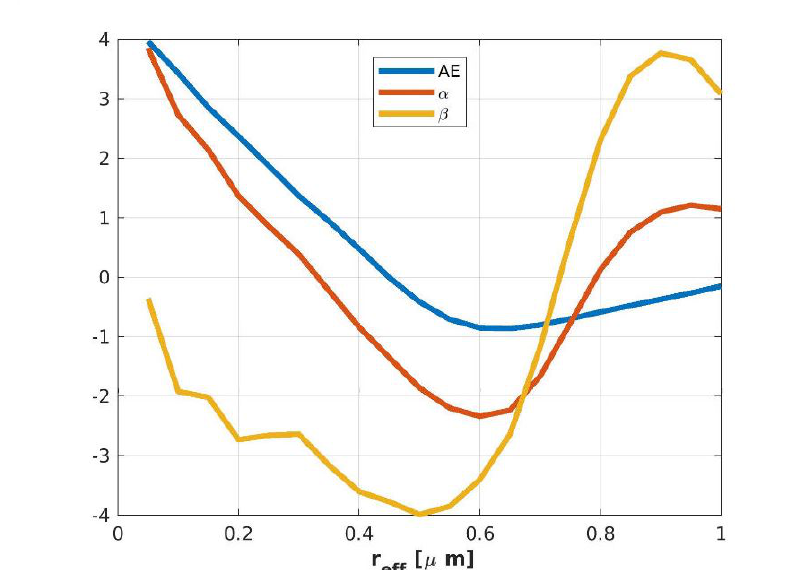
Figure A1. Mie calculus for a homogeneous aerosol layer with a refractive index on n = 1.44 + 10 − 5 i and a standard deviation of σ =